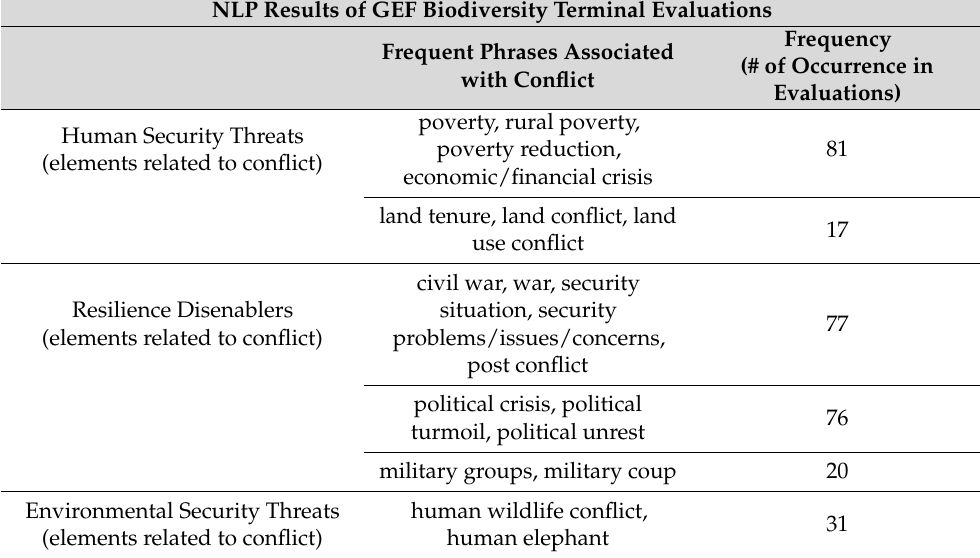
Table 3. Phrases frequently associated with conflict in biodiversity project evaluations.